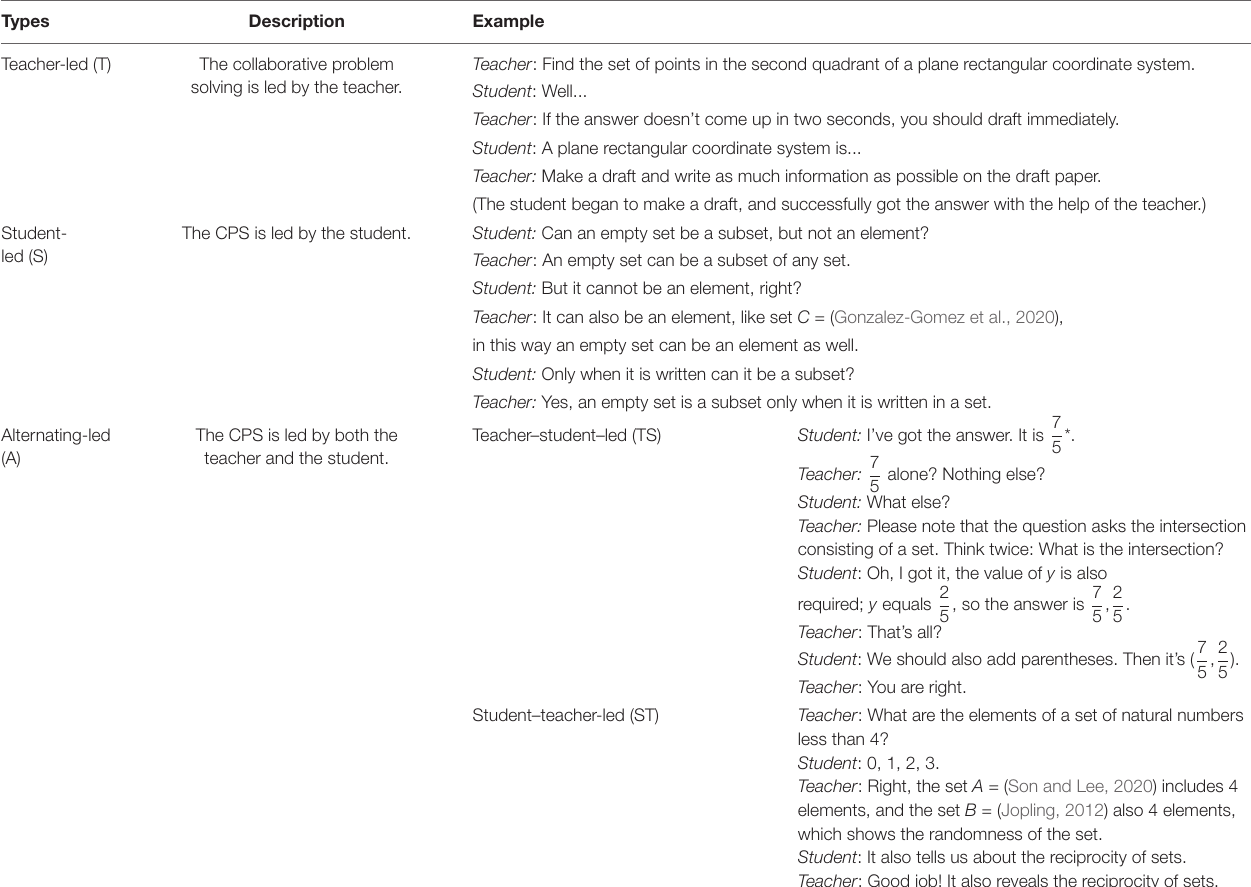
TABLE 2 | The commognitive responsibility shift types of CPS. Types Description Example